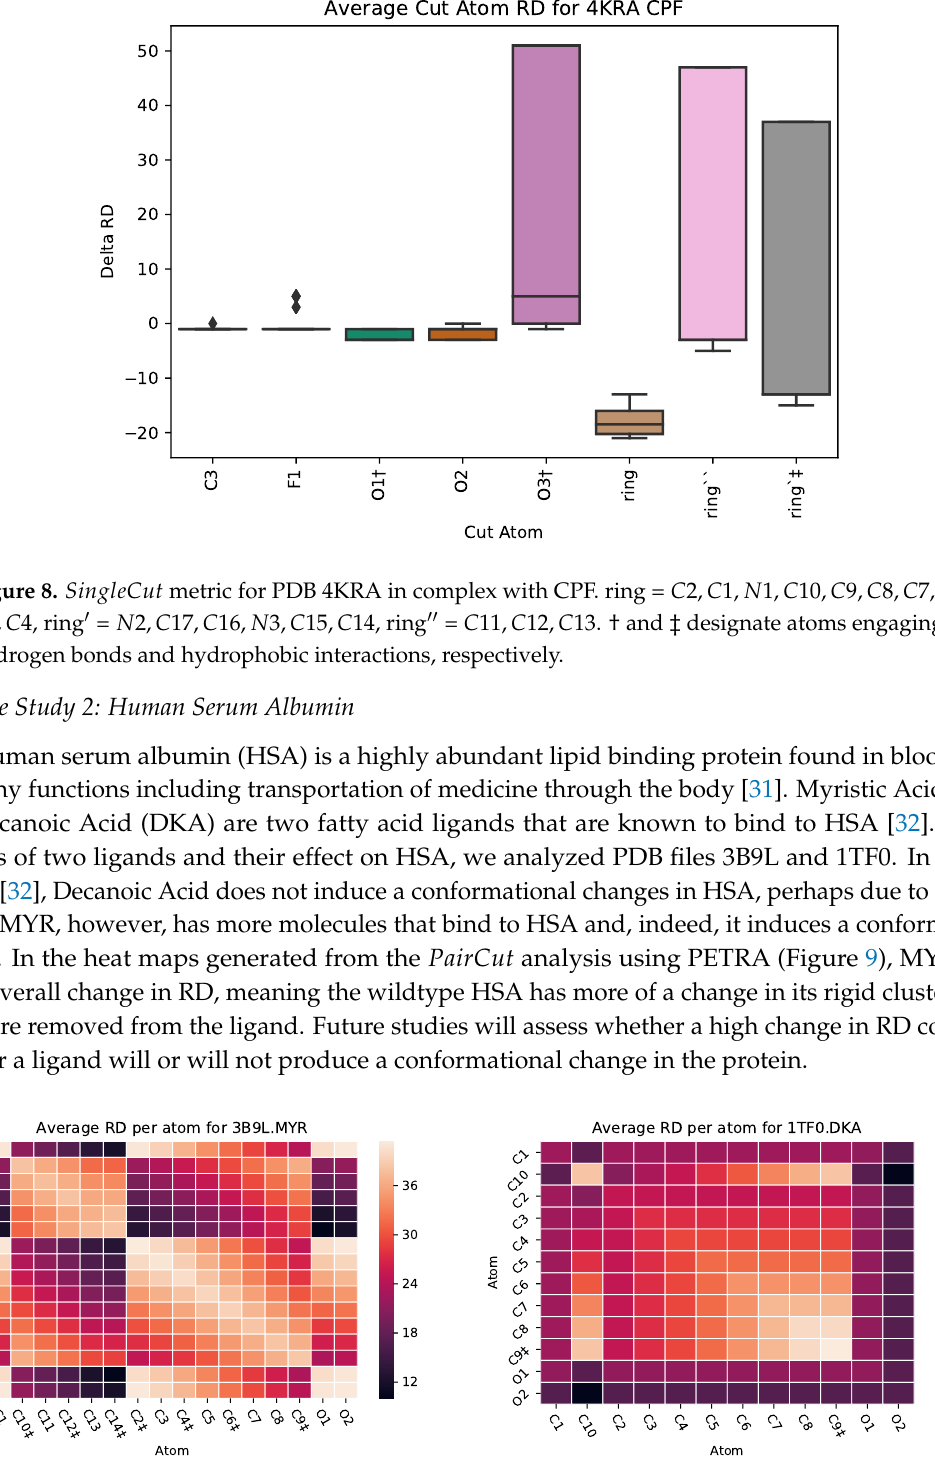
Figure 9. PairCut i , j heatmaps for Myristic Acid in complex with Human serum albumin (HSA) (( left ), PDB 3B9L), and in complex with Decanoic Acid (( right ), PDB 1TF0). ‡ designates an atom engaging in hydrophobic